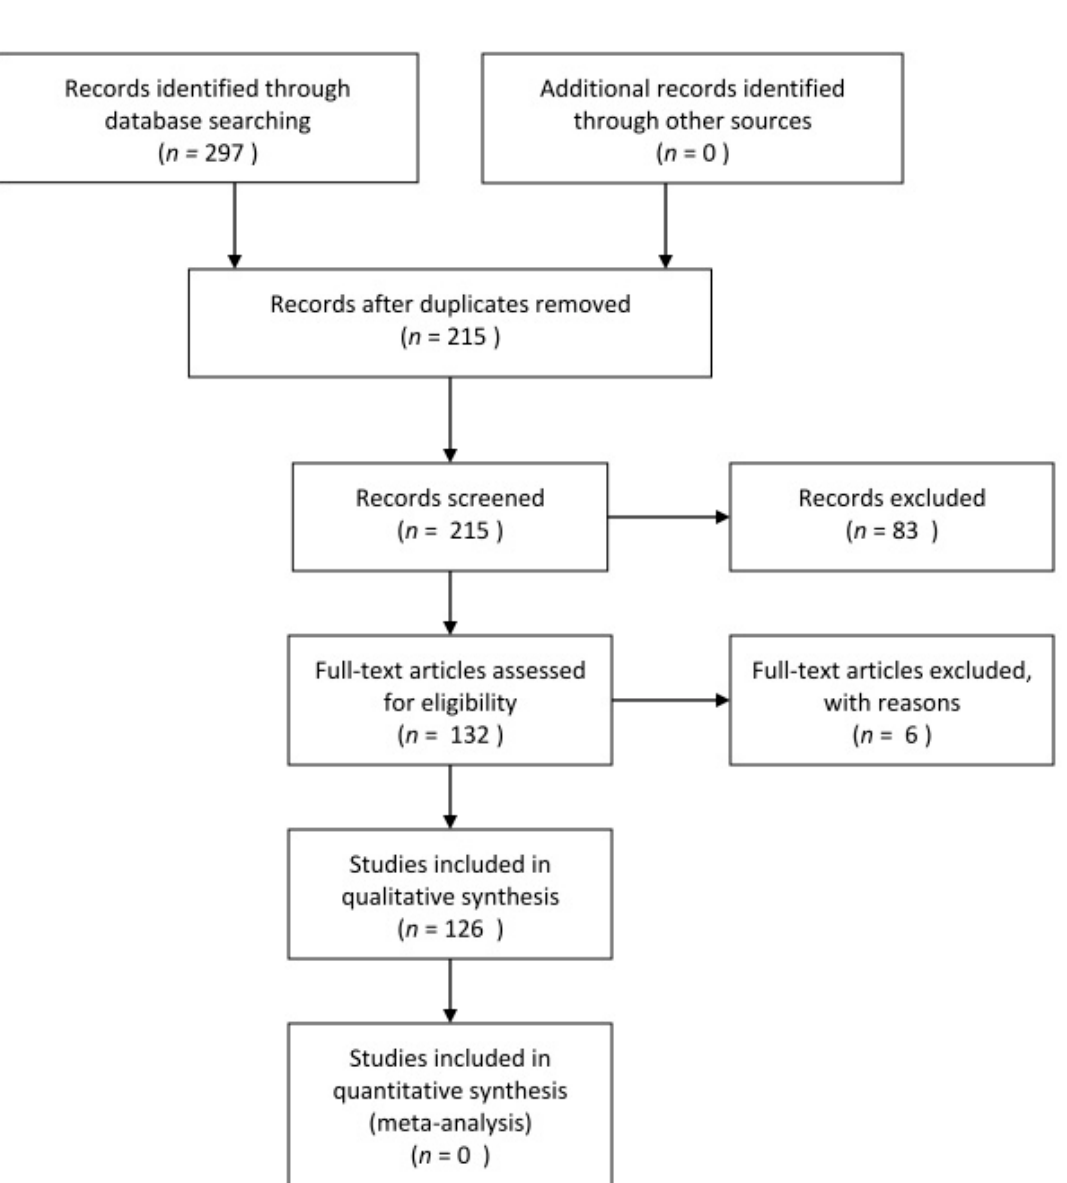
Figure 1. PRISMA 2009 flow diagram of the structured literature review.